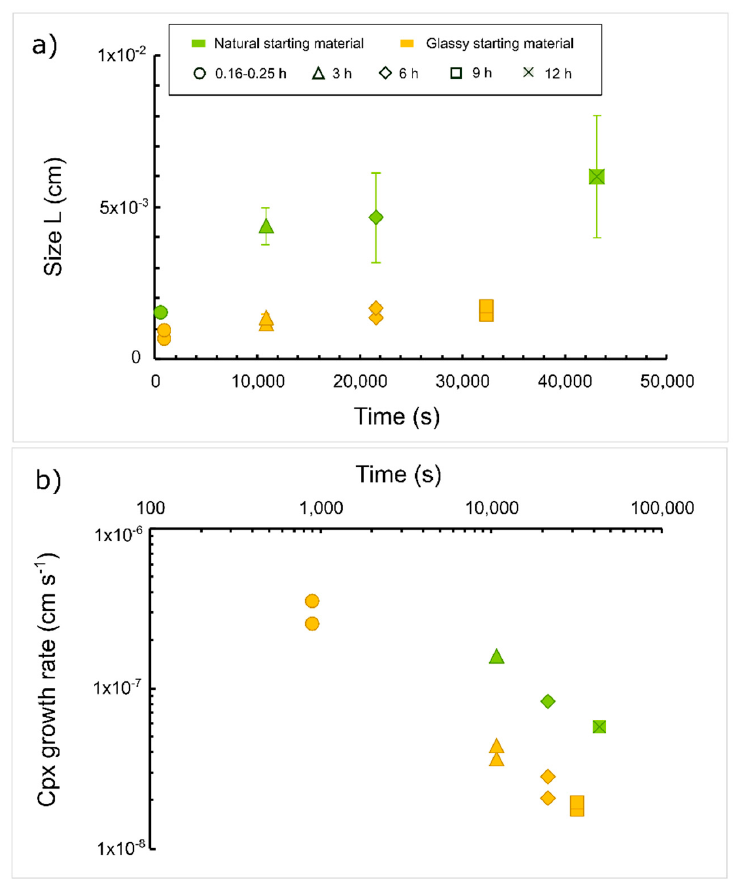
Figure 5. Relation between ( a ) Cpx size ( L ) and experimental time, and ( b ) Cpx growth rate ( G L ) and experimental time. Symbols are as in Figure 2. Error bars are not shown when they are inside the symbols.